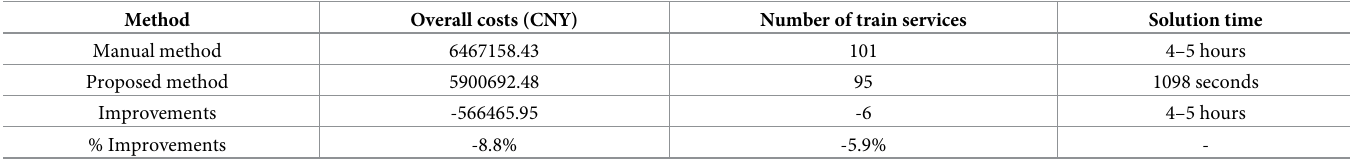
Table 11. Comparisons between the optimal solution and a manual